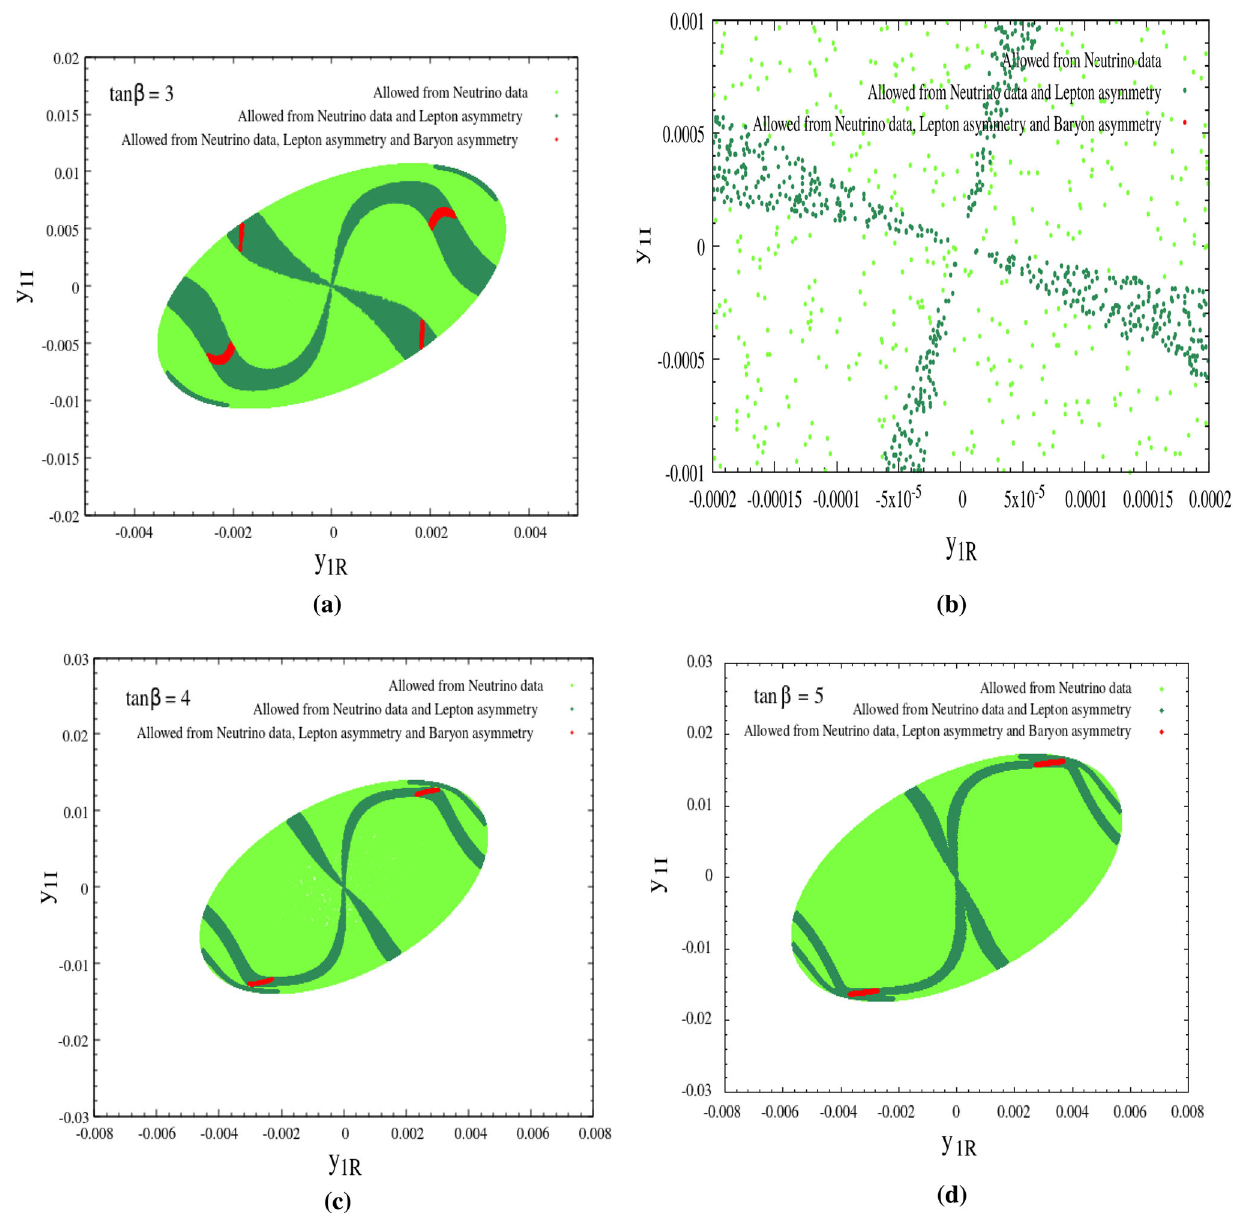
Fig. 7 Parameter space in real vs. imaginary part of Yukawa coupling y 1 . Plots are given for tan β = 3 (upper panel left), tan β = 4 (lower panel left), tan β = 5 (lower panel right). Light green, deep green and red region correspond to the parameter space allowed by only neutrino